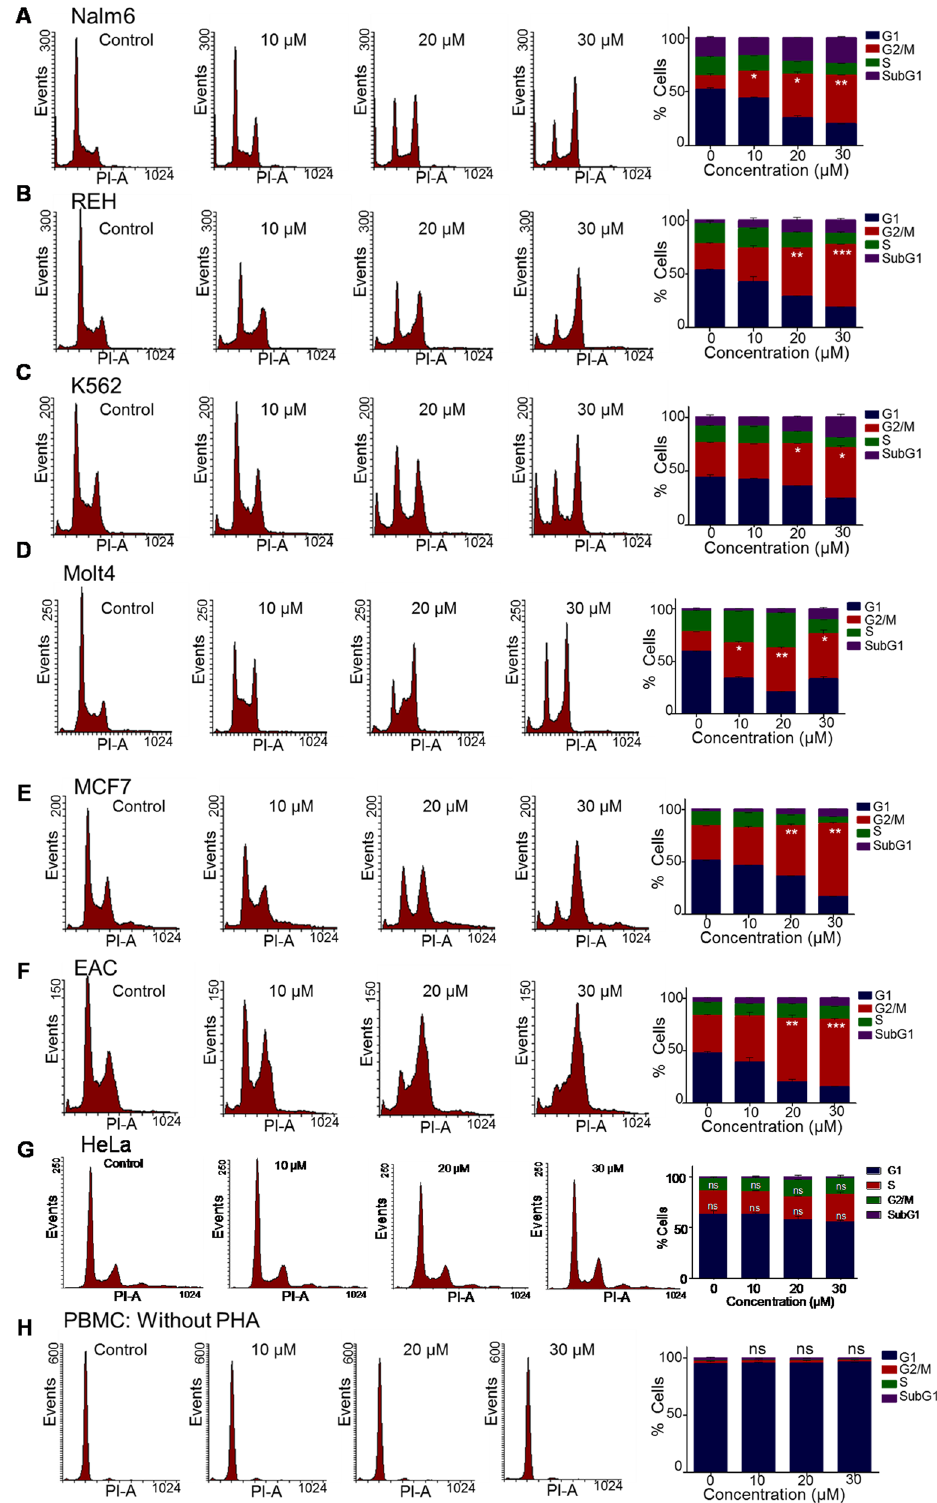
Figure 3. Evaluation of cell cycle arrest in various cancer cell lines following treatment with 5g. Various cancer cells and PBMCs were treated with 5g (0, 10, 20 and 30 µ M) for 24 h, stained with PI and cell cycle analysis was carried out using Flow cytometer. ( A – H ) Histograms showing cell cycle arrest following treatment with 5g in Nalm6 ( A ), REH ( B ), K562 ( C ), Molt4 ( D ), MCF7 ( E ), EAC ( F ), HeLa ( G ) and PBMC ( H ) cells, respectively. Quantification of different phases of cell cycle was carried out and presented with error bars on the right side. Statistical significance was calculated in G2/M population cells using student t-test and significance was shown if the p-value was equal to or less than 0.05 ( * 0.05, ** 0.005, ***